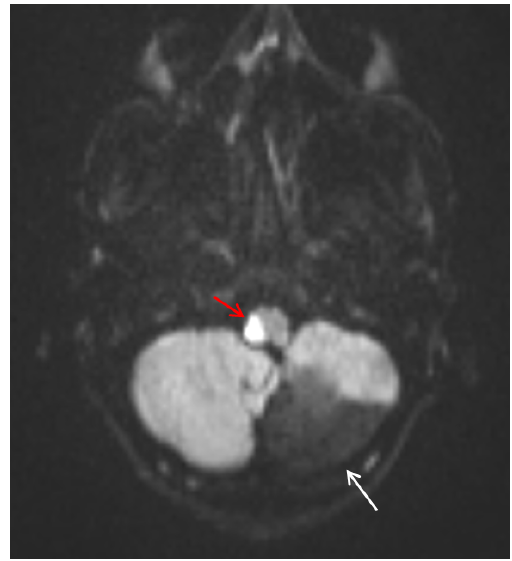
Figure 2: MRI imaging of the brain reveals diffusion restriction in the right medulla oblongata (red arrow) and an old infarction of the left cerebellum (white arrow). Figure 3: Sicca keratopathy of the right eye seen as superficial punctate fluorescein staining of the corneal epithelium